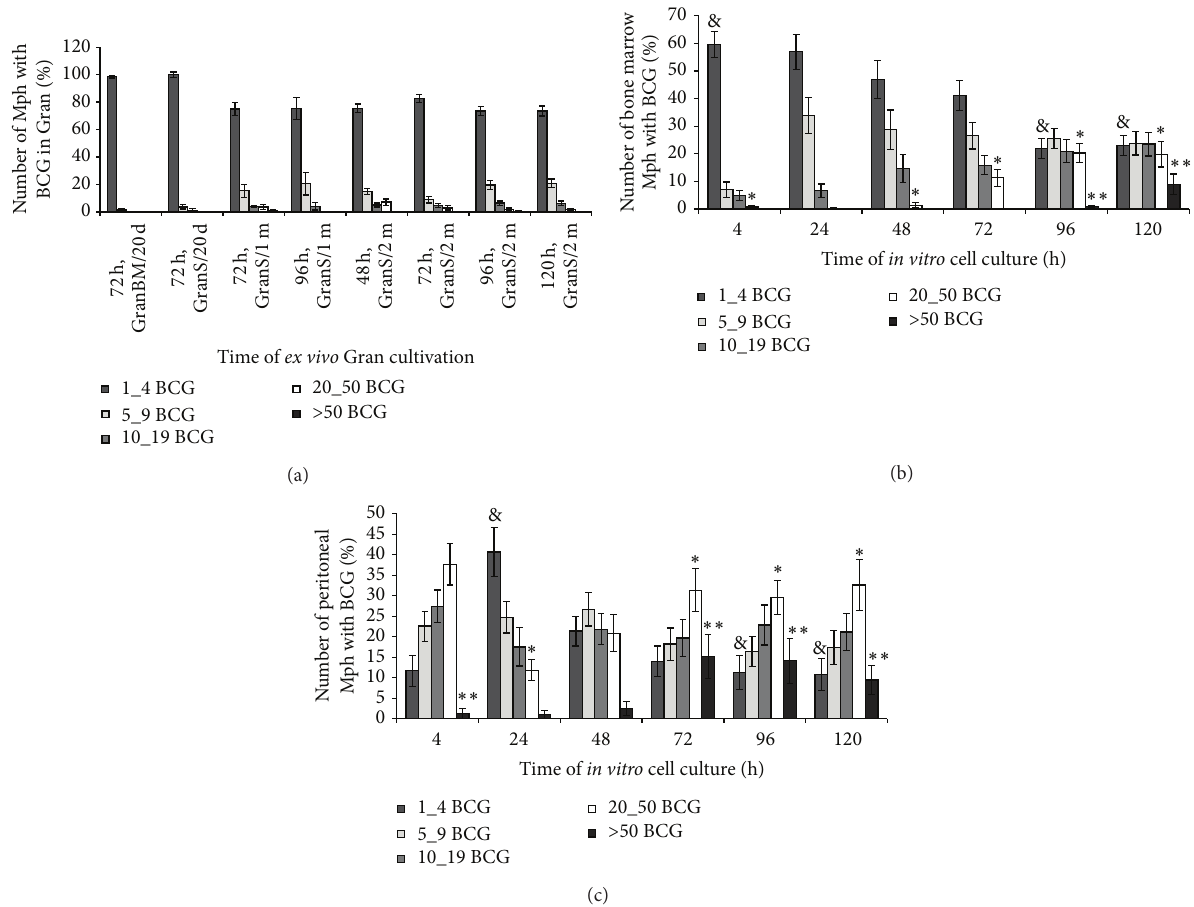
Figure 1: The number of macrophages (Mph) with different numbers of acid-fast BCG-mycobacteria (BCG) in them. (a) Macrophages in 𝑛 granulomas (Gran) obtained from the bone marrow (BM/) and spleens (S/) of mice after 20 days (/20d), one month (/1m), and two months (/2m) following infection with the BCG vaccine in vivo and after ex vivo culture for several hours. The number of macrophages with different numbers of BCG-mycobacteria in granulomas expressed as a percentage of the total number of infected macrophages in granulomas stained by the Ziehl-Neelsen (ZN) method. Data are expressed as the means ± SEM. At hour 48: GranS/2 m (3 mice, 𝑛 = 111 ); at hour 72: GranBM/20d (2 mice, 𝑛 = 29 ), GranS/20 d (2 mice, 𝑛 = 61 ), GranS/1 m (3 mice, 𝑛 = 84 ), and GranS/2 m (5 mice, 𝑛 = 133 ); at hour 96: GranS/1m (1 mouse, 𝑛 = 20 ) and GranS/2 m (4 mice, 𝑛 = 103 ); at hour 120: GranS/2 m (4 mice, 𝑛 = 52 ). (b) Bone marrow macrophages and (c) peritoneal macrophages with different numbers of BCG-mycobacteria following infection with the BCG vaccine in vitro and after culture for several hours. The number of macrophages with different numbers of BCG-mycobacteria expressed as a percentage of the total number of infected macrophages. Data are expressed as the means ± SEM from three independent experiments. In each experiment, more than 1000 cells were analyzed at each time point. P < 0.05 (comparisons of the number of macrophages with 1 4 BCG-mycobacteria & for the following time points (in hours): (b) 4 versus 96 and 120 and (c) 24 versus 96 and 120; with 20 50 BCG-mycobacteria ∗ for the following time points (in hours): (b) 4 versus 72, 96, and 120 and (c) 24 versus 72, 96, and 120; and with > 50 BCG-mycobacteria ∗∗ for time points (in hours): (b) 96 versus 120 and (c) 4 versus 72, 96, and